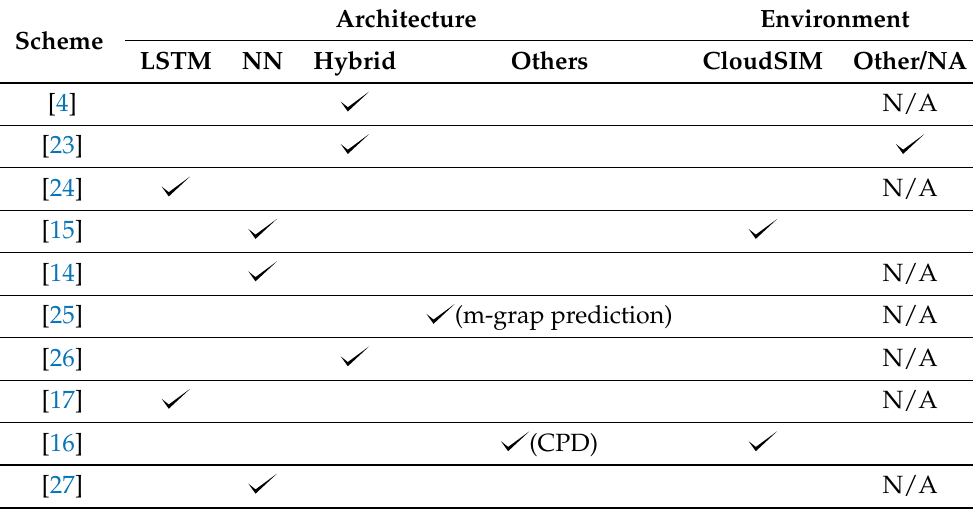
Table 2. Comparison of Architecture type and Simulation Environment of the DL models.